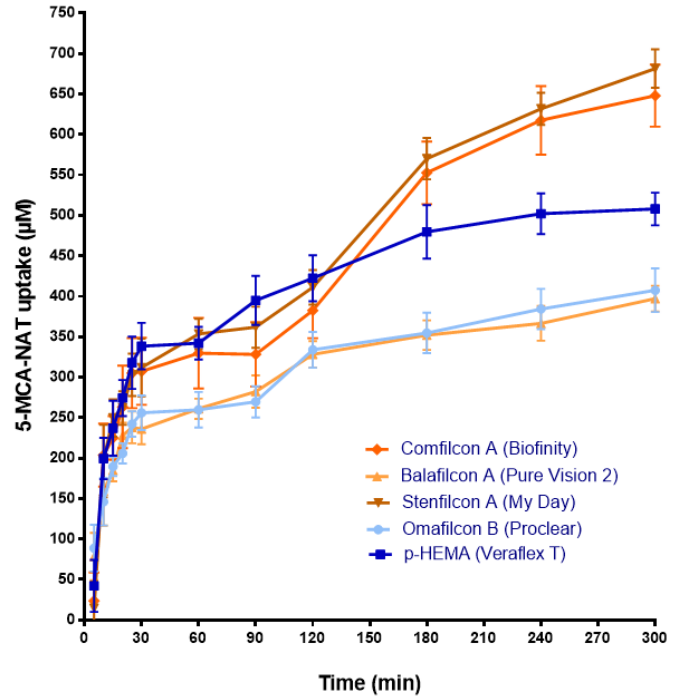
Figure 6. The 5-MCA-NAT absorption by CLs soaked with 5-MCA-NAT solution (1 mL, 1 mM) over 300 min. The concentration ( µ M) values are presented as the mean ± S.D of n = 3 lenses per material. The blue color shows the release from CH CLs. The ochre color shows the release from SH CLs.